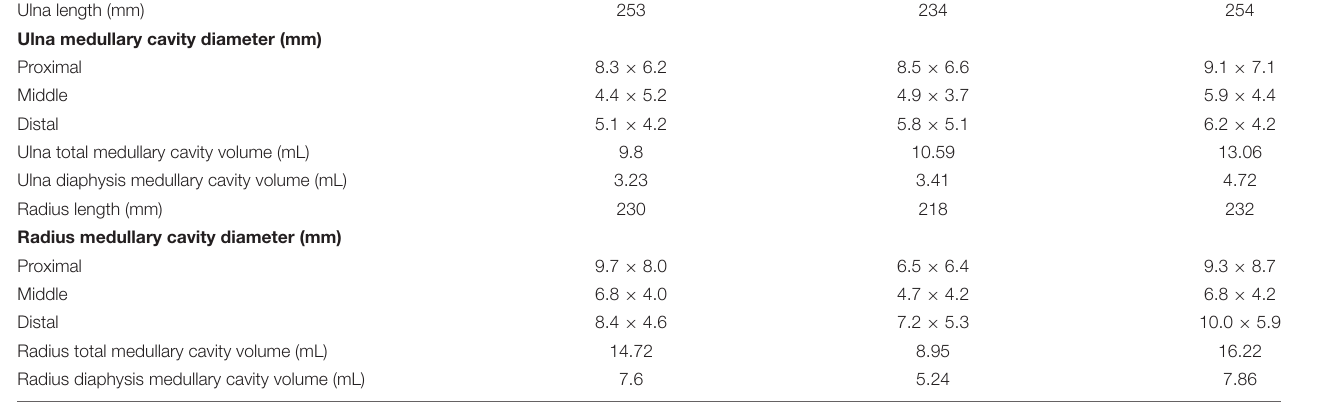
TABLE 4 | Lower extremity bones.